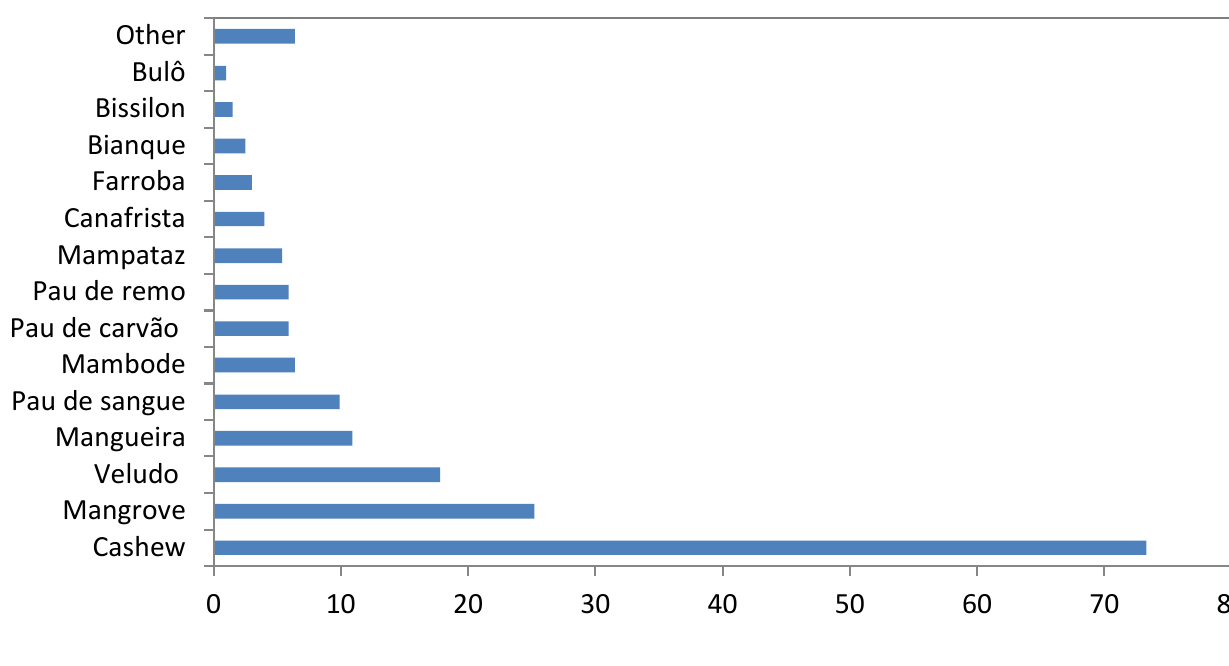
Figure 3. Tree species used for fuel thwood: Bulô—Setara pumila; Bissilon—Khaya